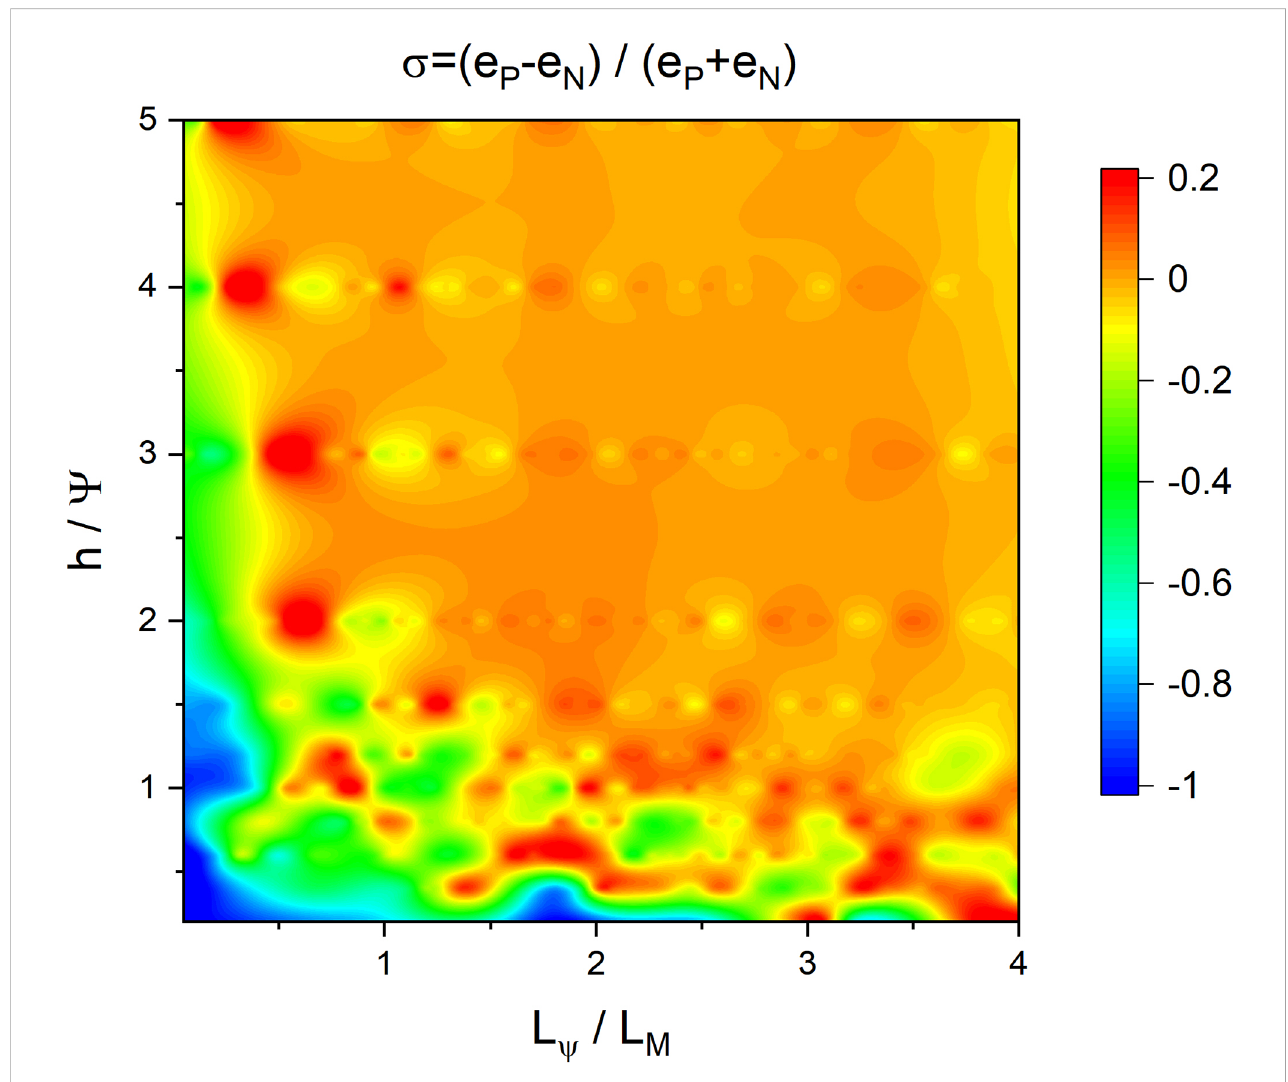
FIGURE 9 s =( e P − e N )/( e P + e N ) from the fi rst 120 eigenmodes as a map of h / Y and L y / L M